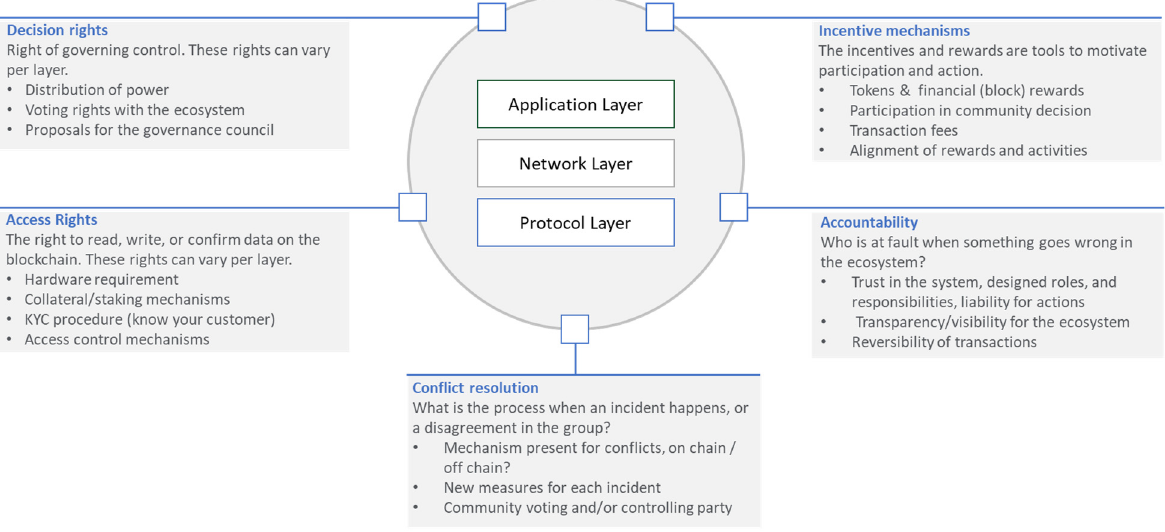
Figure 1. The five behavioral drivers interact with the three layers of the blockchain stack.